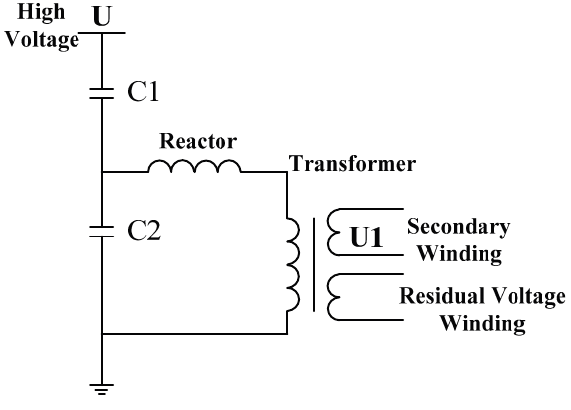
Figure 1. Typical capacitor voltage